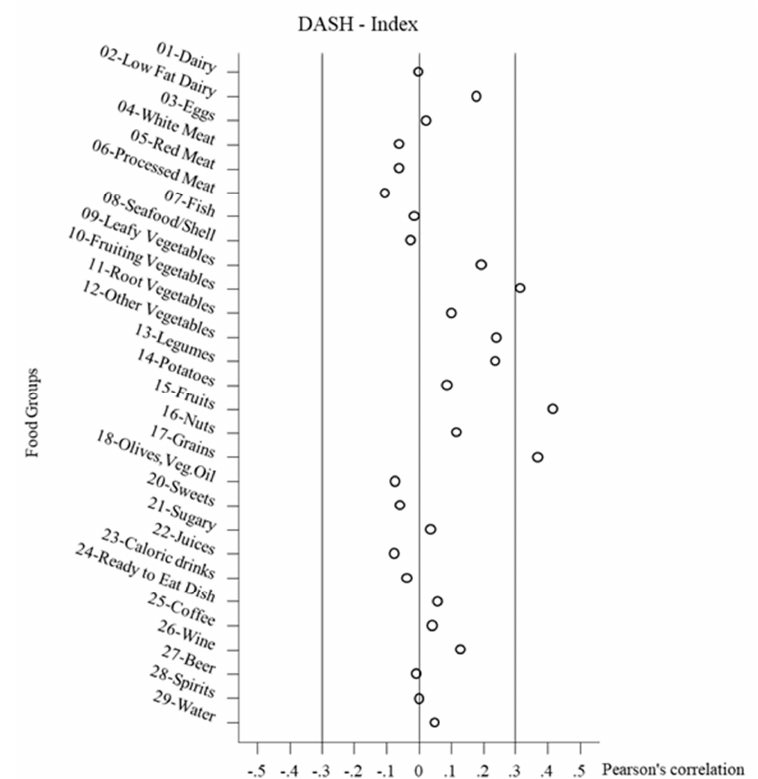
Figure2. Pearson’scorrelationbetweenfoodgroupsintakeandDASH-Index.DASH,dietaryapproaches Figure 2. Pearson’s correlation between food groups intake and DASH-Index. DASH, dietary 314 approaches to stop hypertension. 315 to stop hypertension. Nutrients 2020 , 12 , x FOR PEER REVIEW